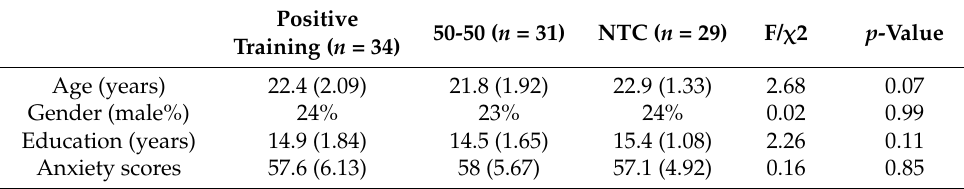
Table 1. Participant demographics [Mean